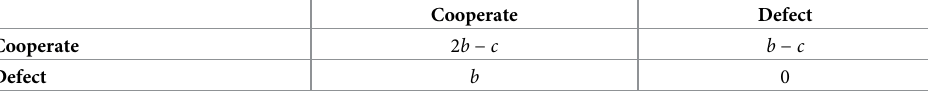
Table 1. Prisoner’s dilemma giving payoffs to interactions, 2 b > c > b > 0. Entries are interaction-payoffs of an indi- vidual whose strategy is given by the row when interacting with an individual whose strategy is given by the